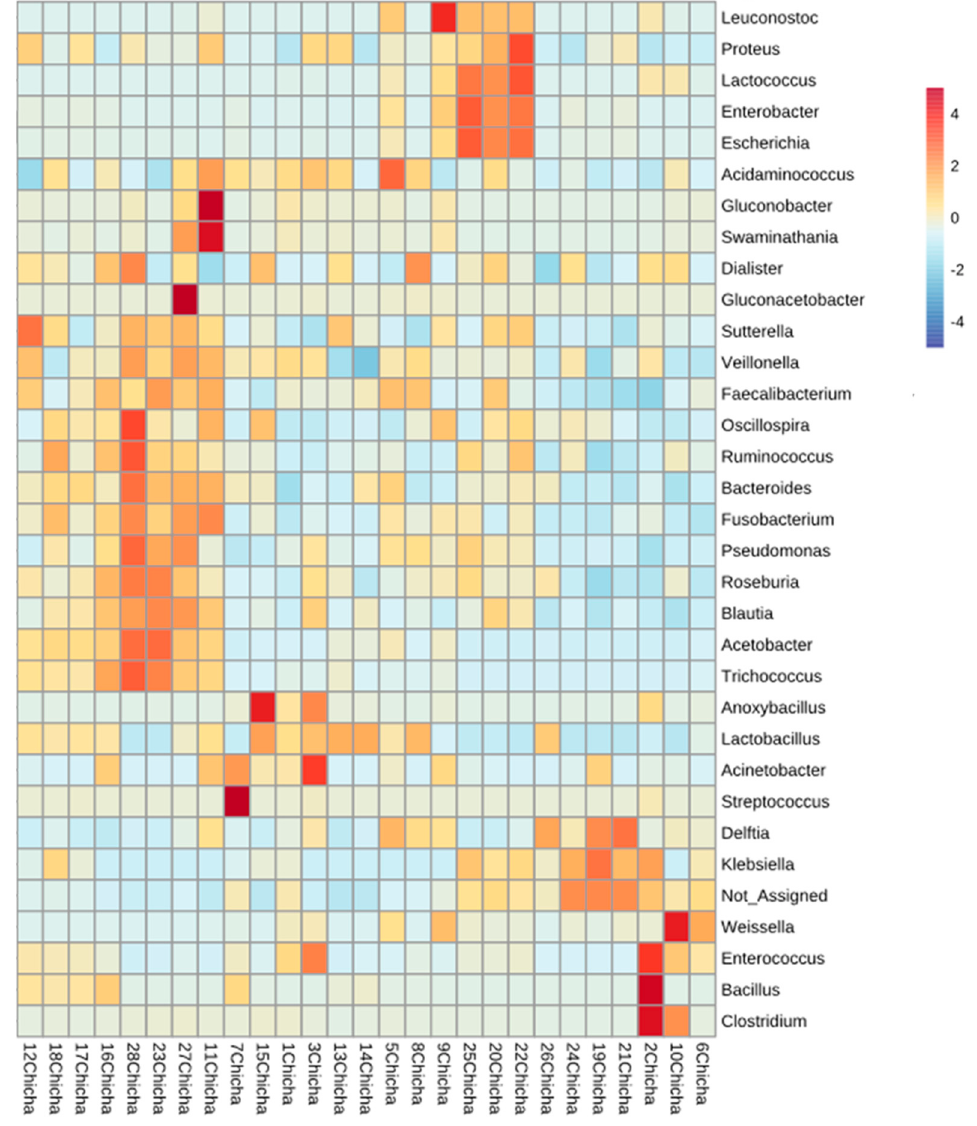
Figure 6. Heatmap showing the relative abundance of all OTUs of bacterial genus associated to chicha samples. Color keys represent square root of relative abundance (in number of sequences).